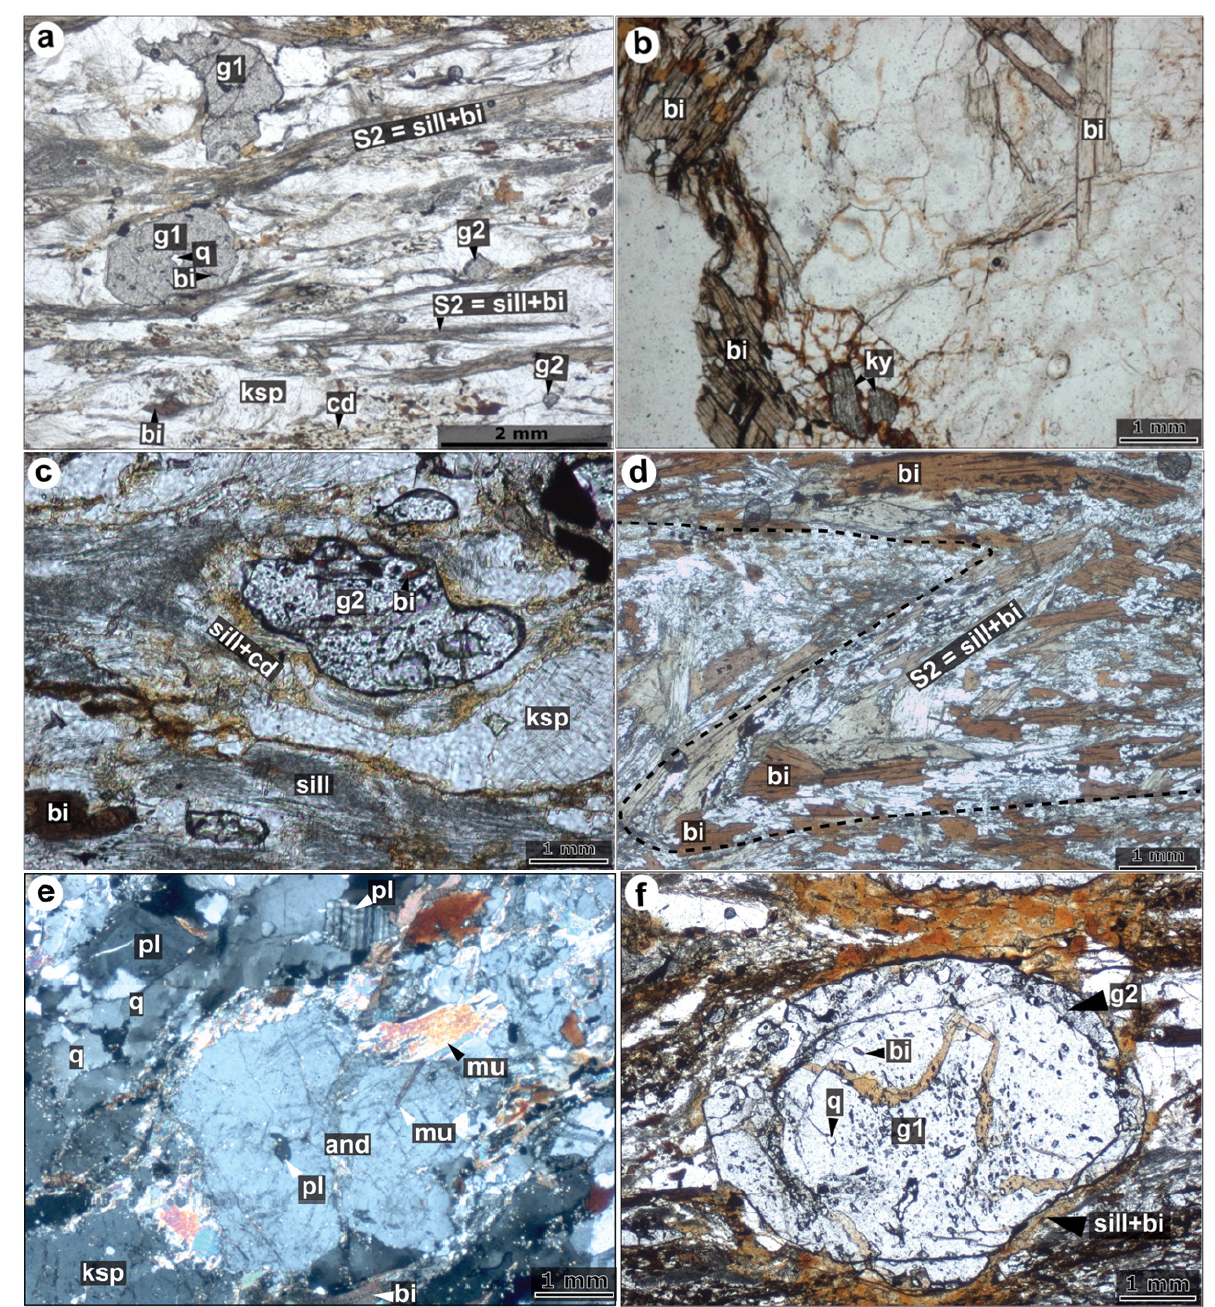
Figure 4. Crystallization/deformation relationships in the migmatitic paragneisses of the Filali unit. ( a ) Two types of garnets are perfectly recognizable: porphyroblasts wrapped by the biotite–sillimanite main schistosity S2 containing inclusion trails of quartz and biotite (S1); small garnets dispersed in a bed of quartz and k-feldspar and slightly wrapped by sillimanite and biotite; garnet porphyroblasts (g1), and garnet with a small size (g2). ( b ) Pre-S2 kyanite porphyroclasts wrapped by the biotite–sillimanite foliation. ( c ) Transformation of a second-generation garnet (g2) into cordierite and sillimanite. ( d ) Foliation S2, defined by biotite and sillimanite, is folded. ( e ) Late-S2 Subhedral andalusite porphyroblast includes plagioclase and muscovite inclusions. ( f ) Garnet shows a core (g1), separated by an optical (and chemical) discontinuity from a peripheral zone (g2). Schistosity S2, composed of sillimanite, biotite, and garnet 2, parallel to thin leucosomes, wraps around large crystals of garnet 1, surrounded by rims of garnet